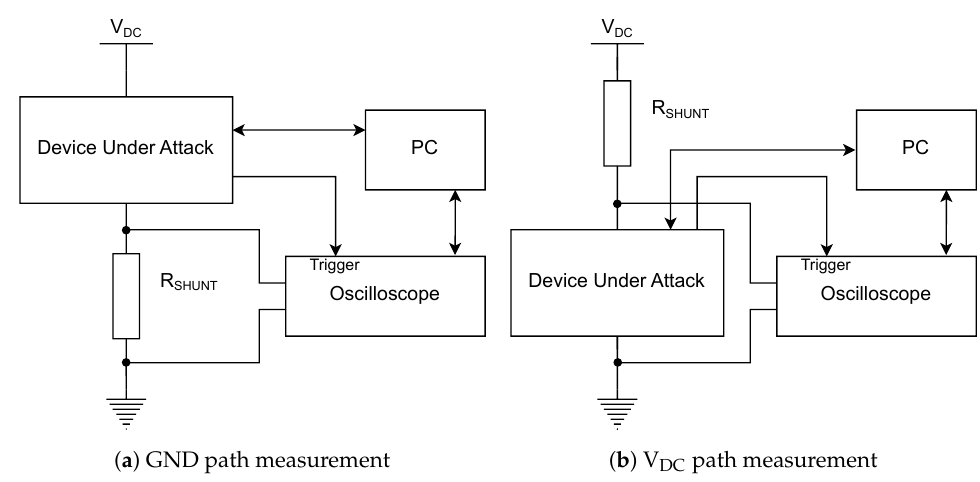
Figure 4. Example of a power measurement